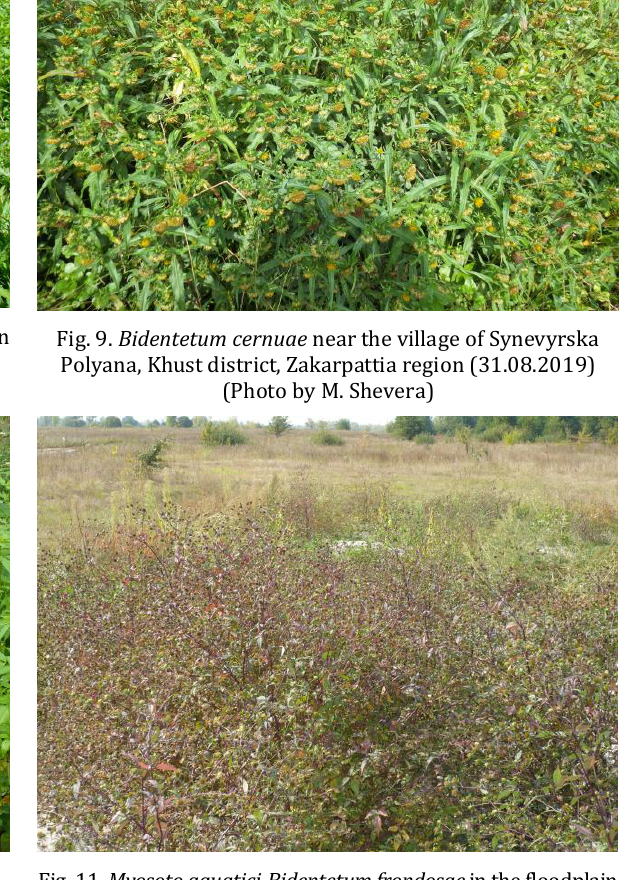
Fig. 10. Bidentetum tripartitae on the left bank of the River Fig. 11. Myosoto aquatici-Bidentetum frondosae in the floodplain Desenka (near the city of Kyiv, Kyiv region, 26.08.2019) of the River Dnieper (near the village of Protsiv, Boryspil (Photo by L. Makhynya) district, Kyiv region, 15.07.2019). (Photo by L.